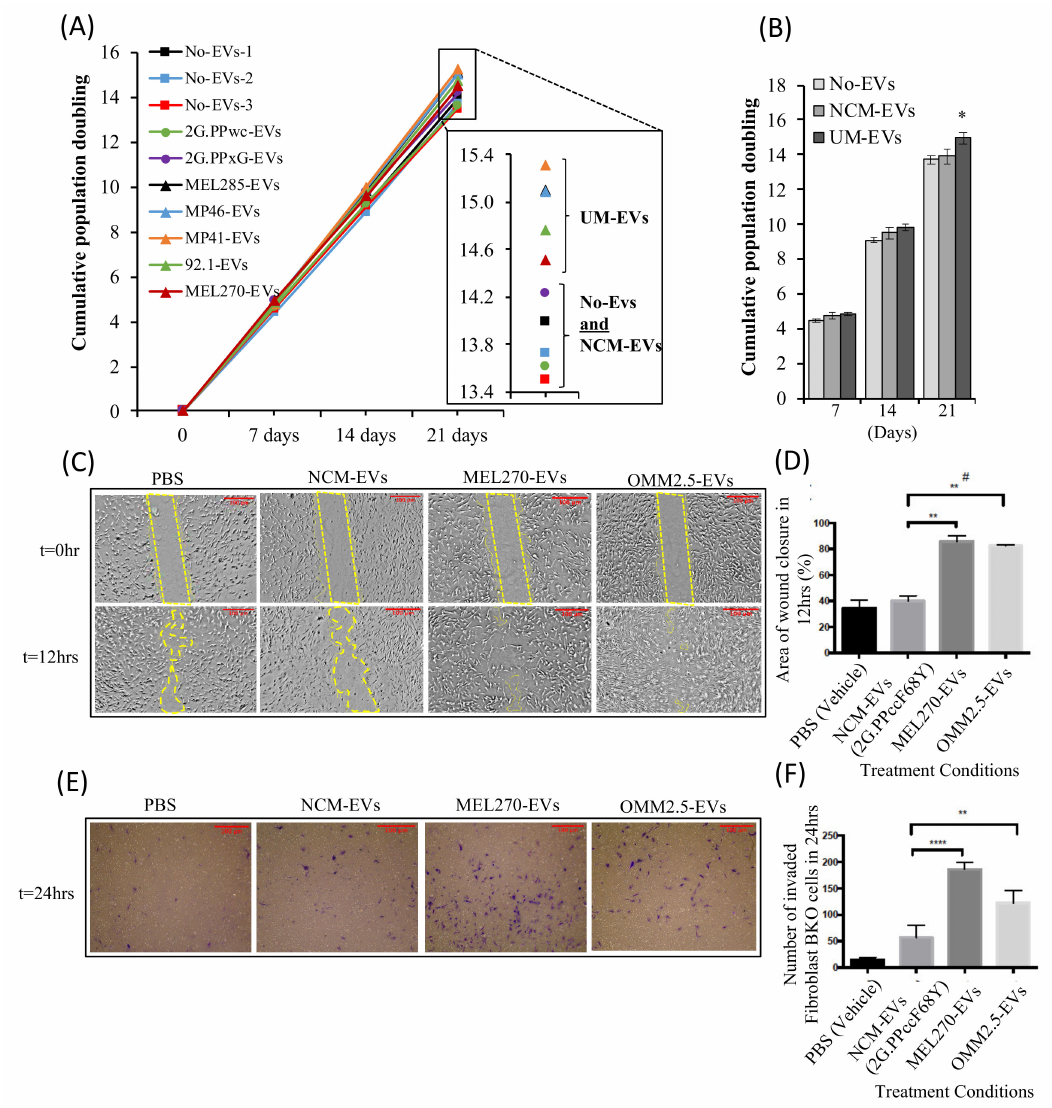
Figure 3. UM-EVs promote proliferation, migration and invasion of BRCA1-deficient fibroblast (Fibro-BKO) cells. ( A – C ) Fibro-BKO cells were cultured for 3 weeks in the presence of culture medium without EVs (No-EVs), NCM-EVs (from PPWc and PPxG eye donors) or UM-EVs. ( A , B ) Cells were analyzed for their growth potential by measuring population doubling capability at every passage. Data in inserts represent cumulative population doublings at the end of the treatment periods ( A ). Column graphs represent pooled data from three EV-free medium (No-EVs) samples, two NCM-EVs preparationsandfive UM-EVspreparations. Data are mean ± SD. p values < 0.05(*) ( B ).( C – F )Fibro-BKO cells were cultured for 12 h ( C , D ; cell migration) or 24 h ( E , F ; cell invasion) in the presence of culture medium without EVs (PBS), NCM-EVs or UM-EVs. Data are mean ± SD. ( D ) p value = 0.0086 (**), p value = 0.0051 (#). ( F ) p value = 0.0072 (**), p value < 0.0001 (****), MEL270 UM-EVs / OMM2.5 UM-EVs, p value = 0.0033 (**) ( n = 3). Scale bar:100 µ m, magnification 100 ×